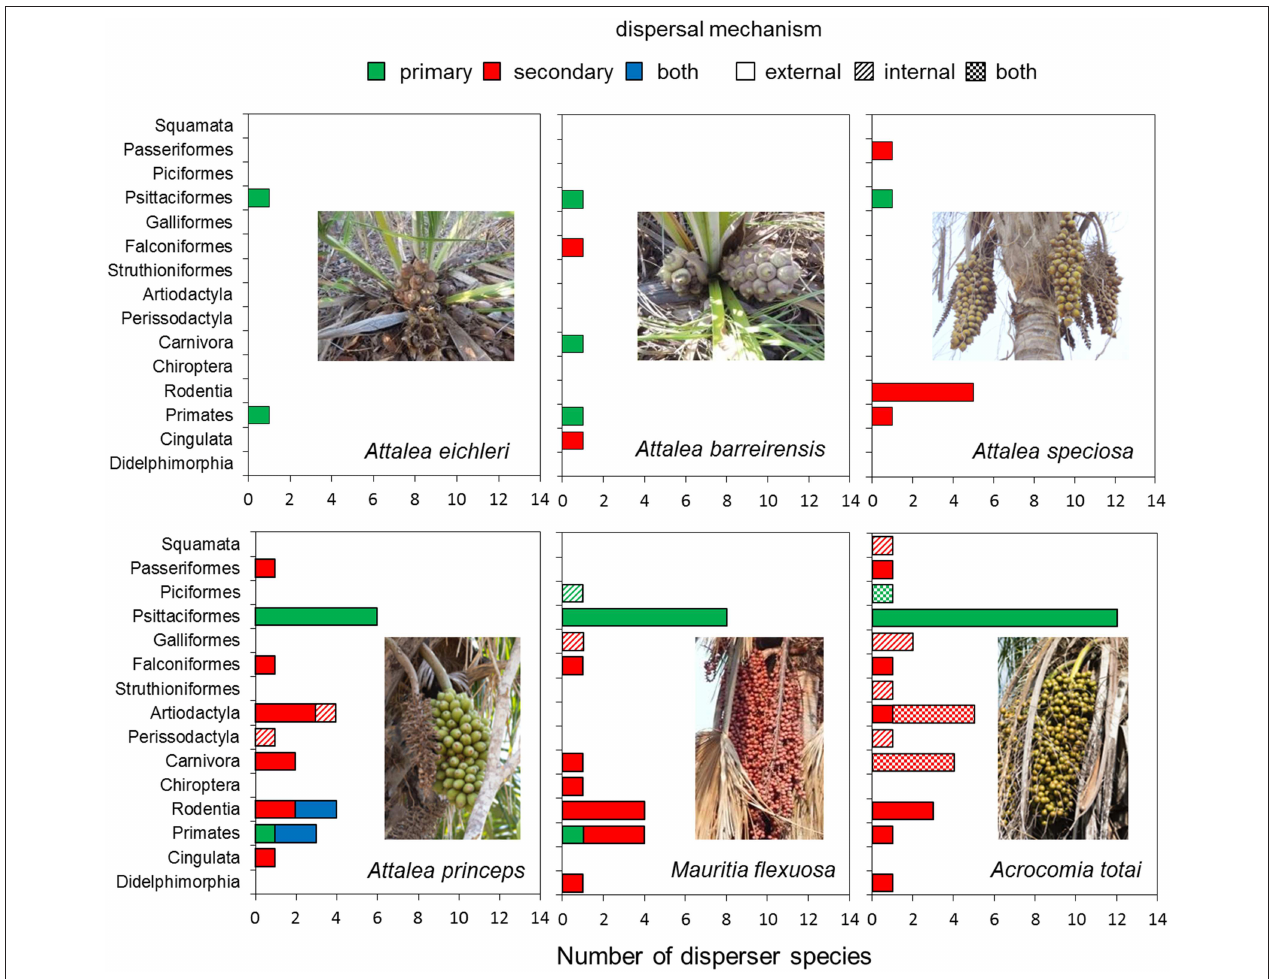
FIGURE 2 | Number of seed disperser species of each vertebrate Order for each palm species according to dispersal mechanism.